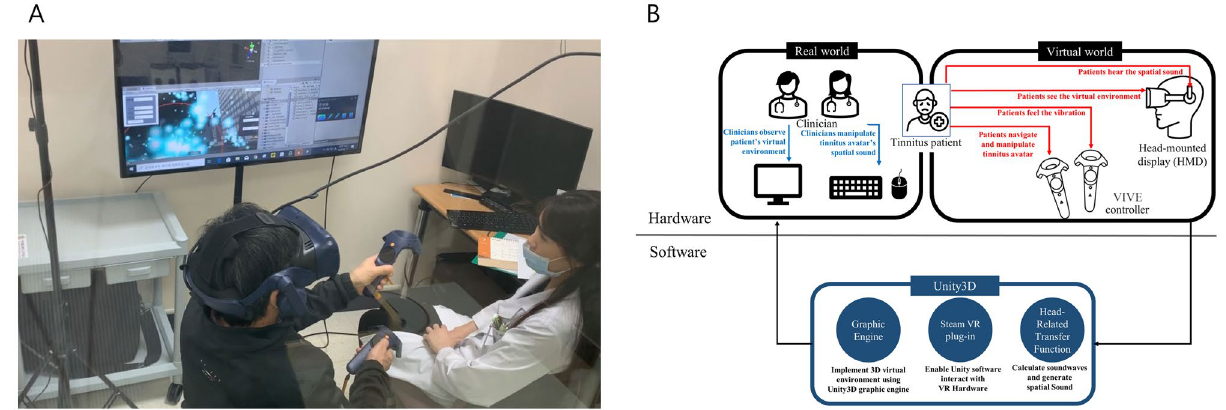
Figure 1. Tinnitus treatment experiment setup. ( A ) The patient and the clinician view the virtual environment through a head-mounted display (HMD) and on a screen, respectively. The patient hears spatial sound from the tinnitus avatar through the HMD headphone. The patient also moves the tinnitus avatar using a VIVE controller. ( B ) Hardware and software setups.